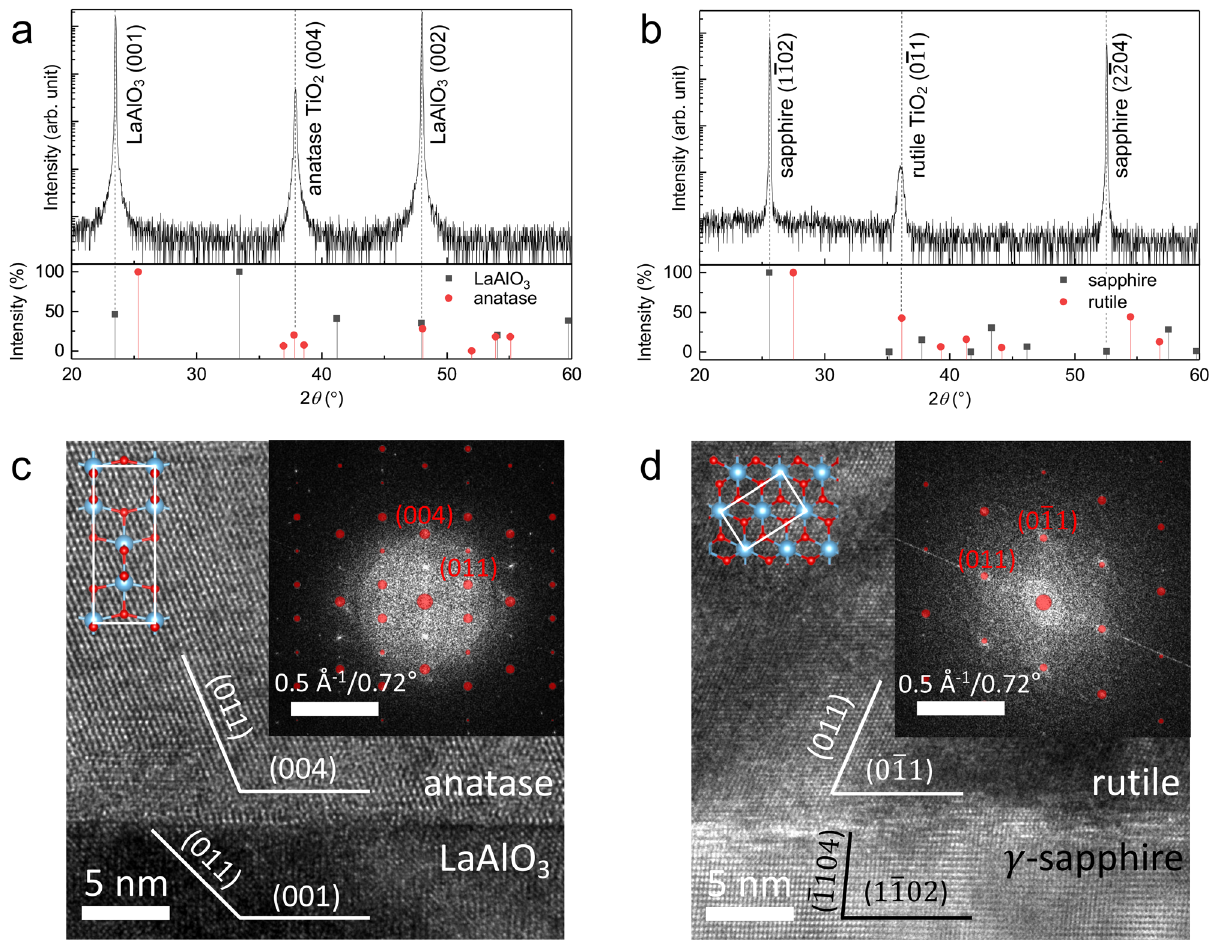
Figure 1. Crystallographic properties of epitaxial anatase and rutile TiO 2 thin films. X-ray diffraction data of ( a ) epitaxial anatase TiO 2 thin film/LaAlO 3 and ( b ) rutile TiO 2 thin film/γ-sapphire (top) with corresponding International Centre for Diffraction Data ( ICDD; bottom, LaAlO 3 , ICDD 98-017-0772; anatase TiO 2 , ICSD 98-000-9852; sapphire, ICDD 01-089-3072; rutile TiO 2 , ICDD 03-065-0192). Cross-sectional HRTEM images of: ( c ) anatase TiO 2 thin film/LaAlO 3 and ( d ) rutile TiO 2 thin film/γ-sapphire. The insets of ( c ) and ( d ) (top left) show crystal structure of the anatase and the rutile phases, respectively. White rectangles represent a unit cell. The insets of ( c ) and ( d ) (top right) show the FFT patterns and simulated results (red circle) of the anatase TiO 2 thin film and rutile TiO 2 thin film,